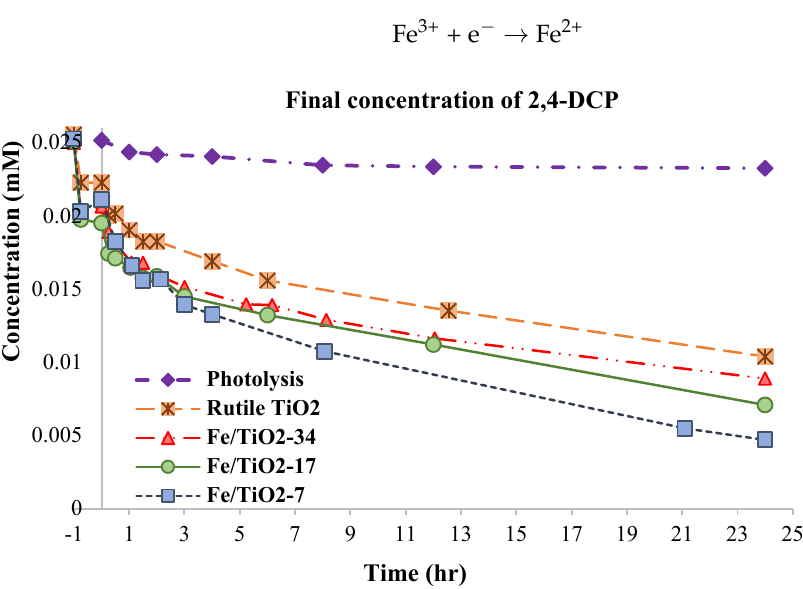
Figure 10. Plots of the 2,4–DCP concentrations during photocatalytic oxidation reactions over the rutile TiO 2 , Fe/TiO 2 –34, Fe/TiO 2 –17, and Fe/TiO 2 –7 under visible light irradiation. Note: [2,4–DCP] 0 = 4.08 mg/L, [TOC] 0 = 9.47 mg/L, catalyst loading = 1 g/L, room temperature, no pH adjustment.